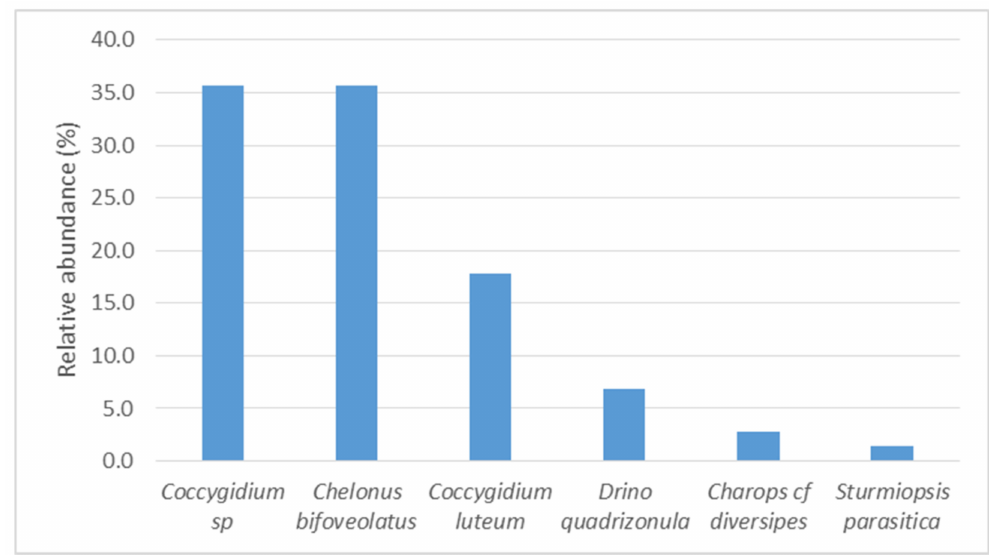
Figure 3. Relative abundance of parasitoid species of Spodoptera frugiperda larvae in 2017 across all surveyed districts in Uganda.